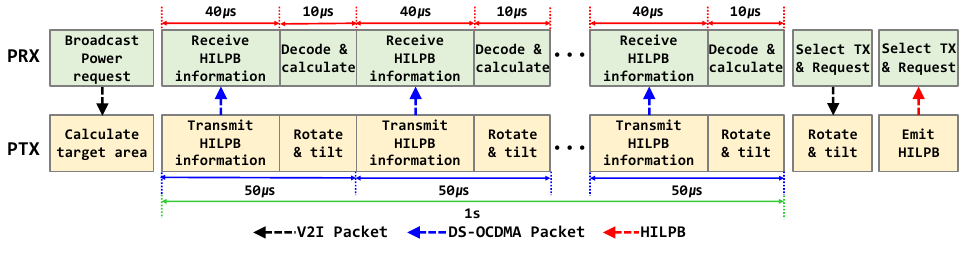
Figure 12. Timeline for WPT protocol.